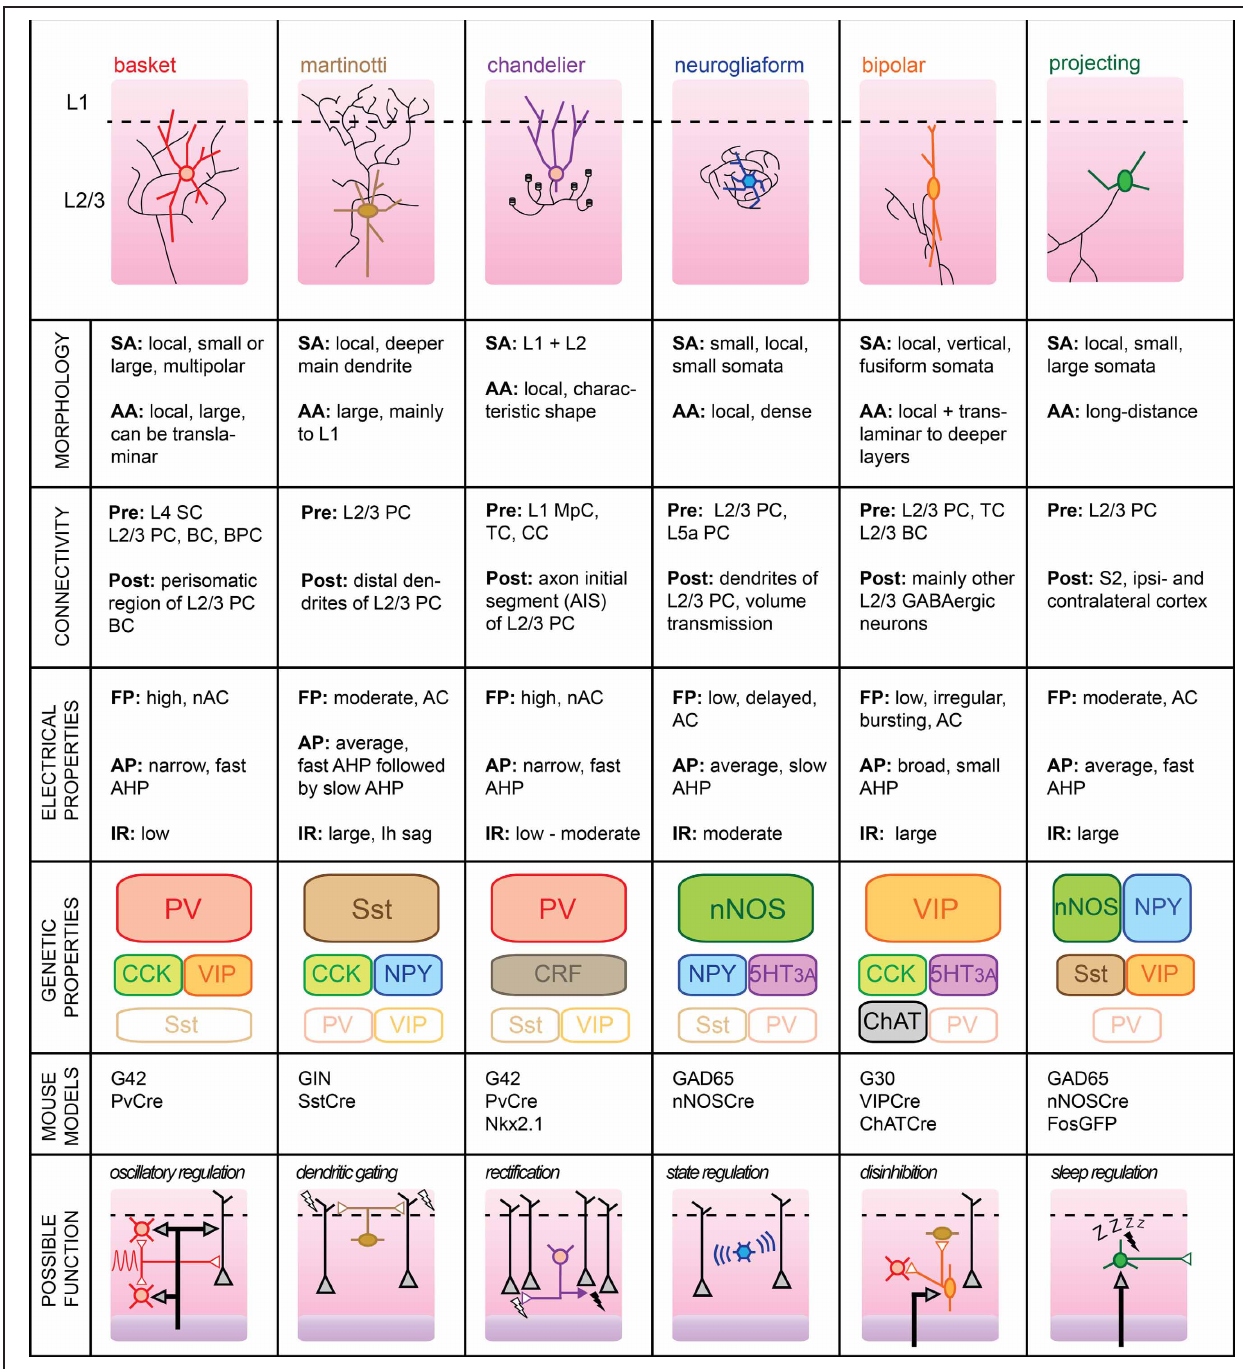
FIGURE 2 | Subtypes of cortical GABAergic neurons in layer 2/3. Top : schematic representation of neuronal morphology. Thick colored lines: somatodendritic arborization; thin black lines: axonal arborization. Abbreviations per row. Morphology, SA , somato-dendritic arborization; AA , axonal arborization. Connectivity, Pre , presynaptic source; Post , postsynaptic target; SC , Spiny stellate cell; PC , pyramidal cell; BC , basket cell; BPC , bipolar cell; TC , thalamocortical afferents; CC , corticocortical afferents; MpC , multipolar cell. Electrical properties, FP , firing pattern; low , < 100Hz maximal firing rate; moderate , 100–150Hz; high , > 150Hz; AC , accommodating; nAC ,